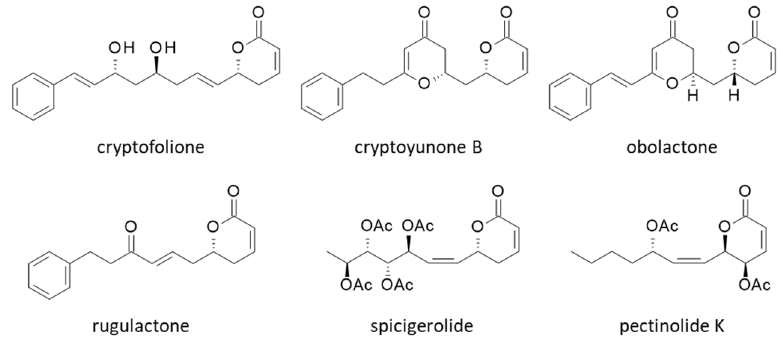
Figure 7. Structures of other pyrone derivatives investigated as α -tubulin binders.